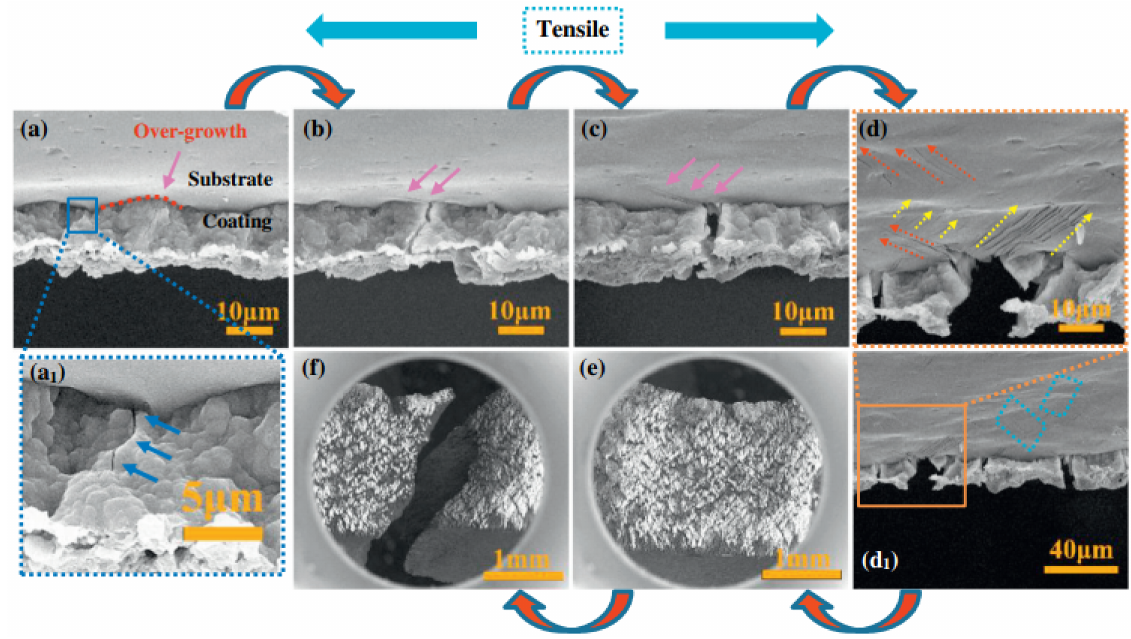
Figure 6. Details of progressive tensile test in the coating/substrate during loading on the cross- section of a PEO-coated sample: ( a ) over-growth regions at the coating/substrate interface, ( b , c ) the crack propagation process, ( d ) further crack opening and propagation inside the substrate, ( e , f ) fracture occurrence